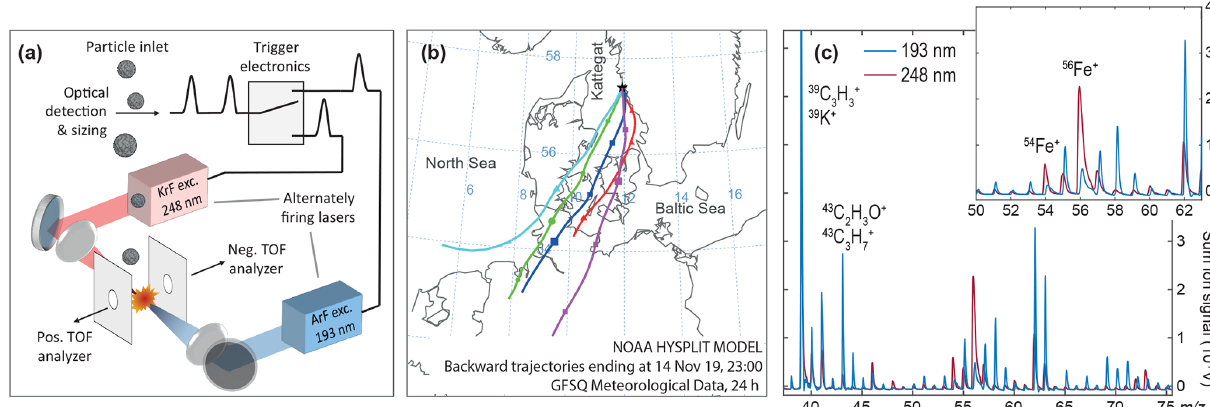
Figure 4. (a) Schematic view of the setup for direct comparison of nonresonant and resonant ionization of Fe in ambient air particles using the same mass spectrometer. The two lasers fired alternately on 15000 particles each. (b) Back trajectories from the HYSPLIT webtool (http://www.ready.noaa.gov/HYSPLIT.php, last access: 13 December 2019) (Stein et al., 2015; Rolph et al., 2017), ending at the sampling site (sea level) during the experiment on long-range transported particles. (c) Accumulated cation mass spectra (every n = 15000) show a Fe + -signal enhancement for ionization with the KrF excimer laser (248nm, red) versus the ArF excimer laser (193nm, blue). Further differences will be discussed in a different